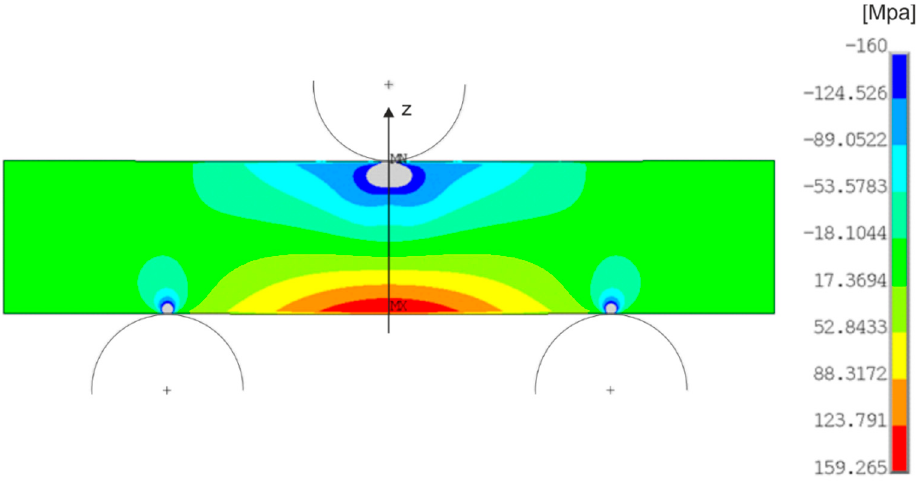
Figure 2. Distribution of principal stresses numerical analysis for material AISI 316L and load 4